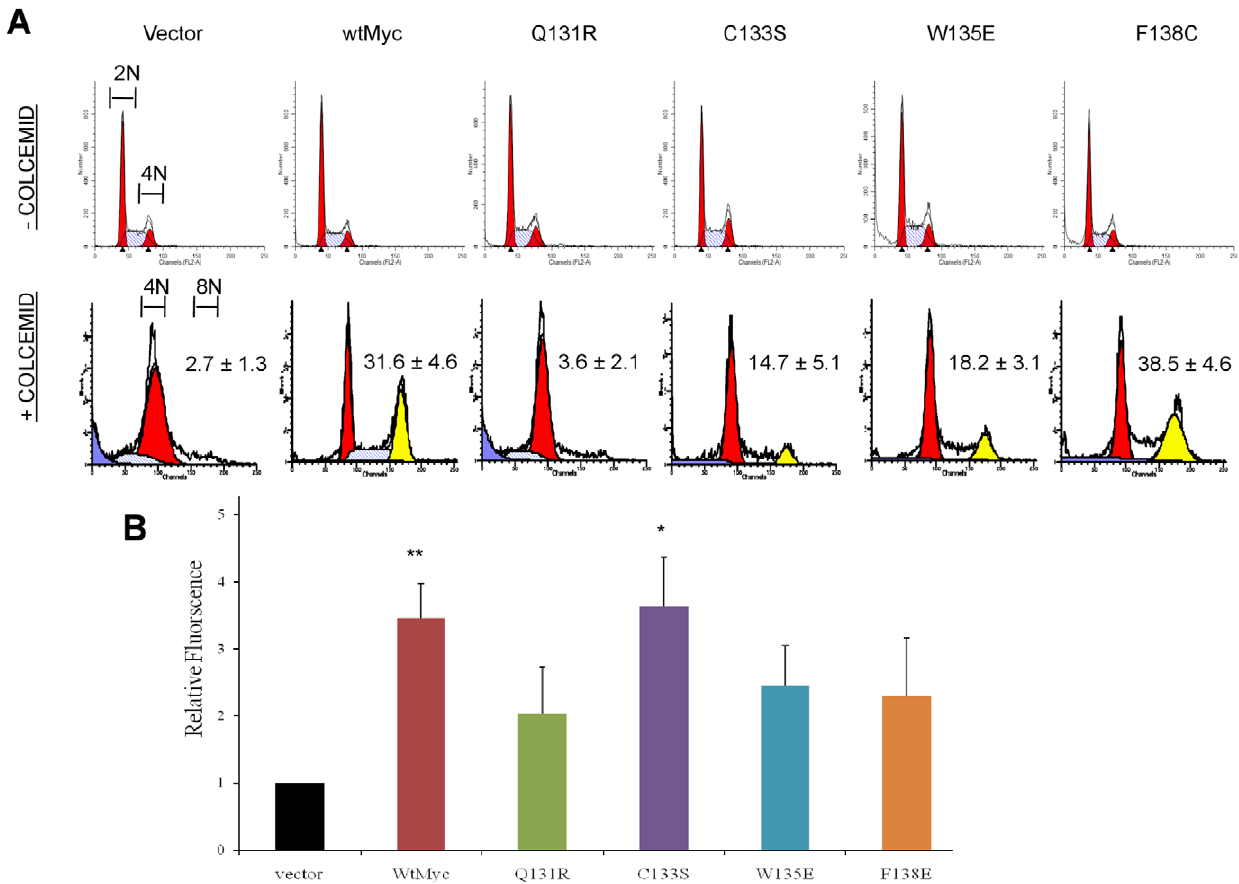
Figure 4. GI induced by Myc proteins. ( a ) Induction of tetraploidy. Each of the depicted cell lines showed indistinguishable cell cycle parameters during logarithmic growth in the absence of colcemid (top row). Treatment of vector cells with colcemid resulted in the expected accumulation of G2/M-arrest cells containing a 4N DNA content, whereas a significant fraction of wtMyc cells accumulated tetraploid DNA content (8N bottom row) [28,58]. Note the varying degrees of tetraploidy induction in all mutant cell lines except Q131R. ( b ) Induction of ROS. Each of the cell lines was exposed to CM-H 2 -DCFDA and was then assessed by flow cytometry. Note the . 3-fold higher levels of ROS in wtMyc cells compared to vector control cells as previously described [33,39] and that only C133S cells were able to reproduce this effect. p-values were calculated by a two-tailed t- test in Microsoft Excel when compared to vector cells: (*) p # 0.05; (**) p # 0.005. Figure 5d). Upon the resumption of electron flow and oxygen